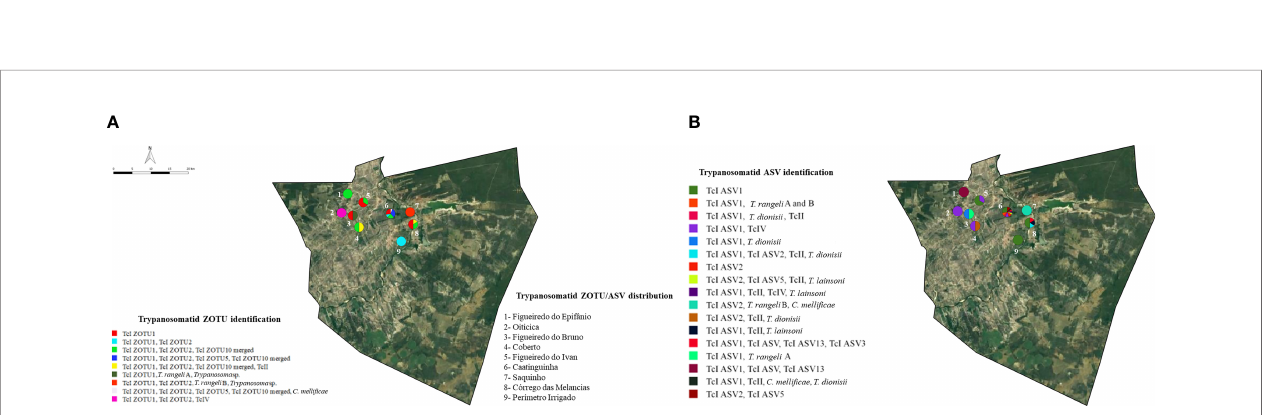
FIGURE 5 | Trypanosoma cruzi DTU TcI haplotype network from D. albiventris , R. rattus , R. nasutus and T. brasiliensis culture samples. Networks were constructed with 18S rDNA (A) The size of each blue node is proportional to the haplotype frequency. (B) ASV haplotype per mammal and triatomine hosts. (C) ZOTU haplotype distribution per mammal and triatomine hosts. The small black circle represents the median vector, which can be interpreted as an unsampled sequence or an extinct ancestral sequence.